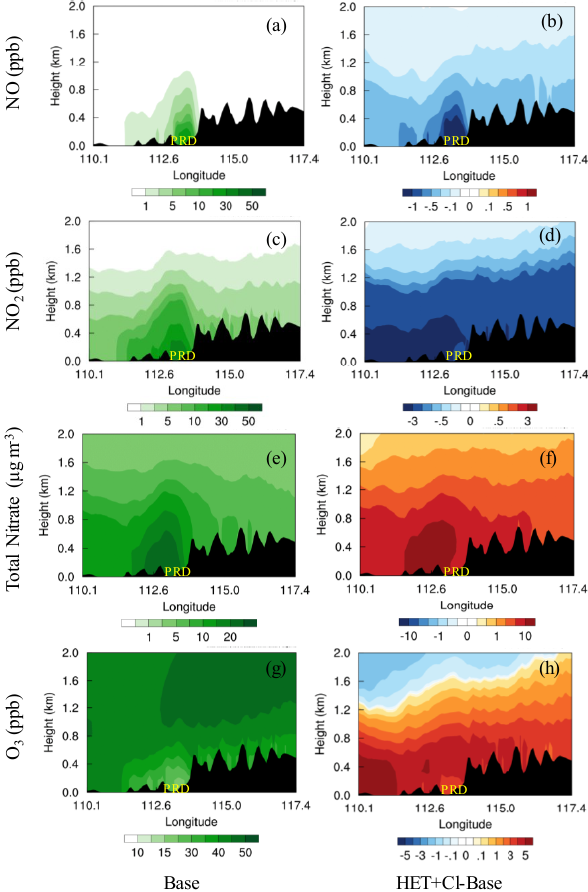
Figure 7. Vertical distributions of (a) NO (ppb), (c) NO 2 (ppb), (e) total nitrate (µgm − 3 ) and (g) O 3 (ppb) average concentrations during the study period in the domain intercepting PRD and along the prevailing wind from the base case; the average impacts of N 2 O 5 uptake and Cl activation on (b) NO (ppb), (d) NO 2 (ppb), (f) total nitrate (µgm − 3 ) and (h) O 3 (ppb) average concentrations during the simulation period in the vertical